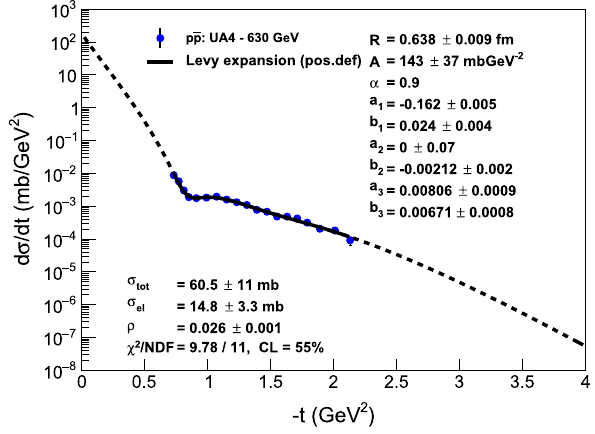
Fig. 27 Third-order Lévy expansion fits of the differential cross- section data on p ¯ p elastic scattering at fixed α = 0 .